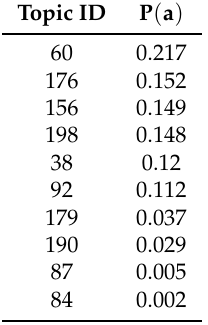
Table 1. An example of an individual’s attribute representation.